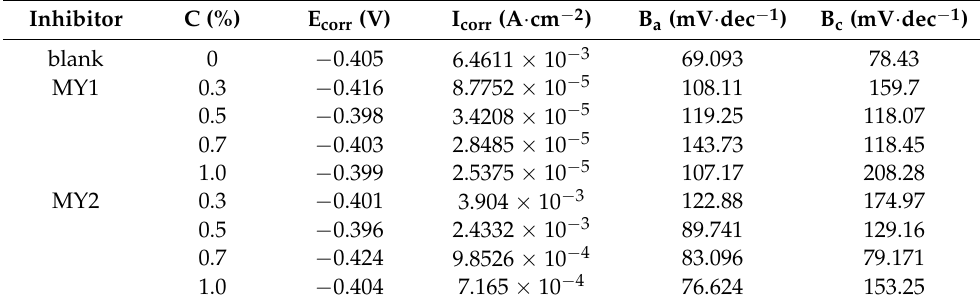
Figure 3. Polarization curves of MY1 and MY2 at different concentrations. Table 1. Fitting electrochemical parameters with different concentrations of corrosion inhibitor.